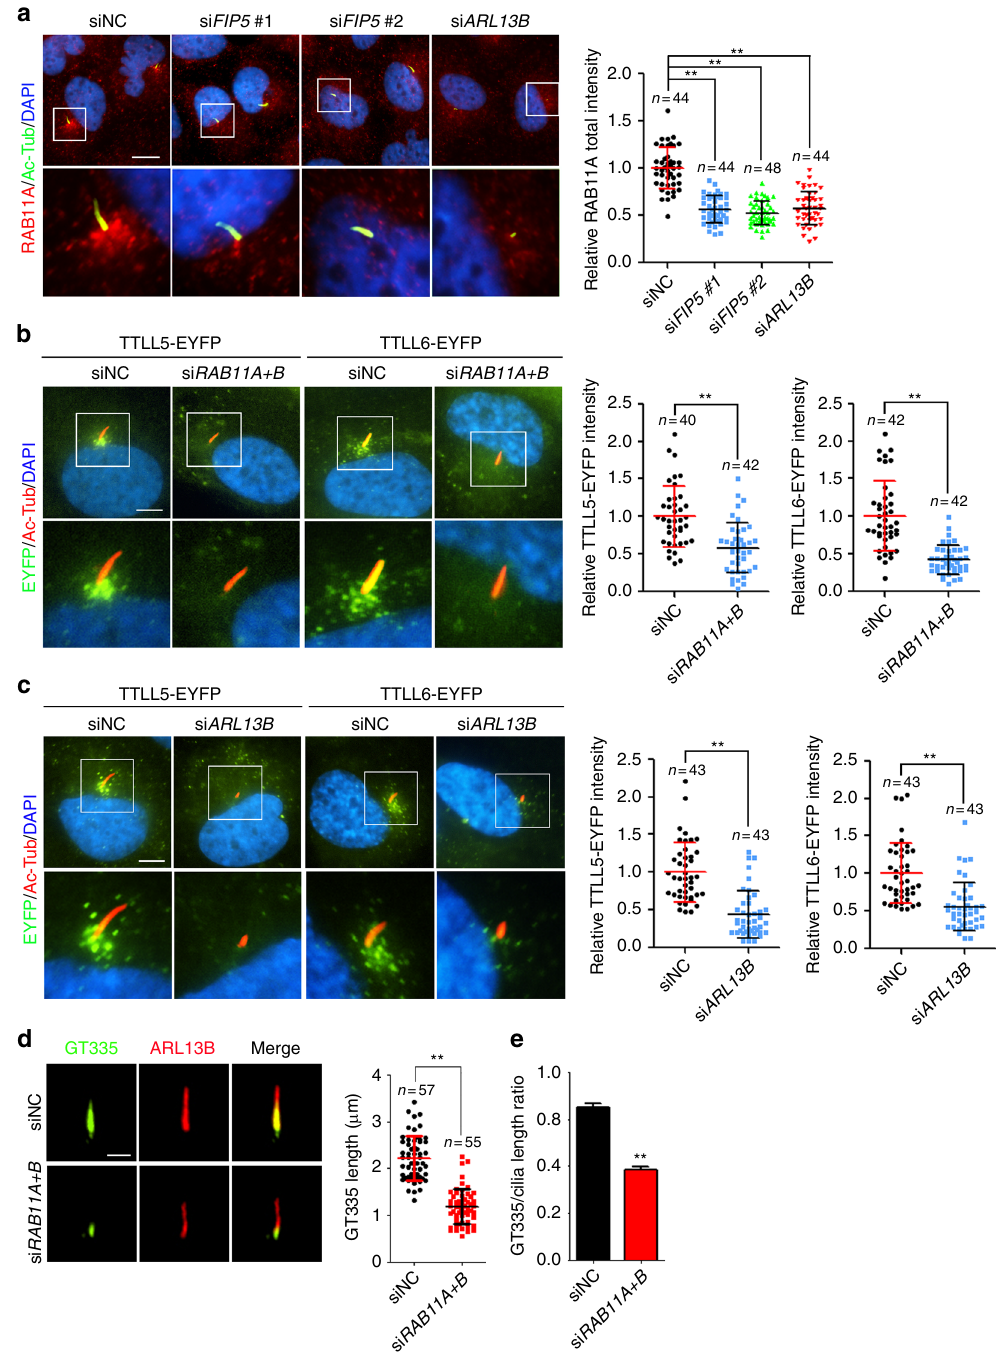
Fig. 3 RAB11 regulates the ciliary import of TTLL5 and TTLL6 in FIP5- and ARL13B-dependent manner. a Depletion of FIP5 or ARL13B impaired ciliary base enrichment for RAB11A-positive vesicles in hTERT-RPE-1 cells. Quanti fi ed of RAB11A total intensity at cilia base (30 μ m 2 area were measured). Scale bar: 10 μ m. b hTERT-RPE-1 stable cells expressing TTLL5-EYFP and TTLL6-EYFP were treated with 20 nM RAB11A + B siRNAs for 48 h and serum starved for 24 h, the impaired enrichment of TTLL5- or TTLL6-positive vesicles at the ciliary base was observed. Quanti fi ed of TTLL5/6-EYFP total intensity at cilia base (30 μ m 2 area were measured). Ac-Tub was immunostained by antibody. Scale bar: 5 μ m. c Depletion of ARL13B compromised the enrichment of TTLL5- and TTLL6-positive vesicles at the ciliary base as seen. Quanti fi ed of TTLL5/6-EYFP total intensity at cilia base (30 μ m 2 area were measured). Ac-Tub was immunostained by antibodies and TTLL5/6-EYFP was shown by direct fl uorescence. Scale bar: 5 μ m. d , e Depletion of RAB11 impaired axoneme polyglutamylation (scale bar: 2 μ m). Quanti fi cation of the length of GT335 signal ( d , right panel) and the (GT335 staining)/(Cilia length) ratio (siNC: n = 57, siRAB11A + B: n = 55 cilia) ( e ) were shown. Center values represent mean. Error bars represent s.d. N value: cilia number accessed from at least six fi elds. Statistical signi fi cance was determined using unpaired Student ’ s t test. ** p <